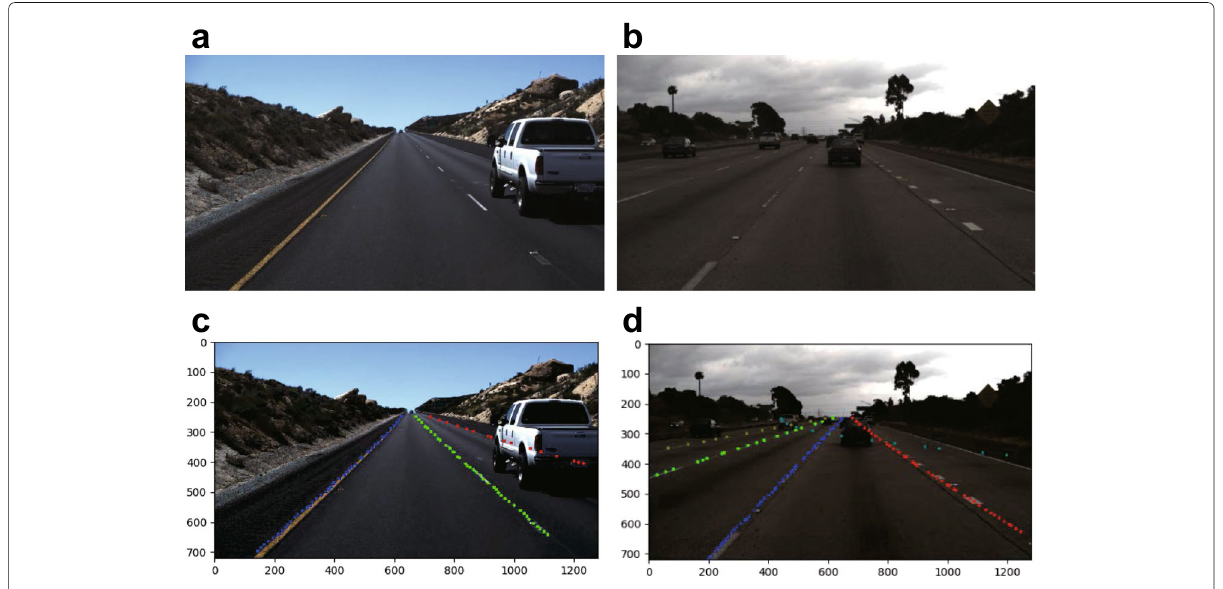
Fig. 3 Lane detection under poor lighting conditions